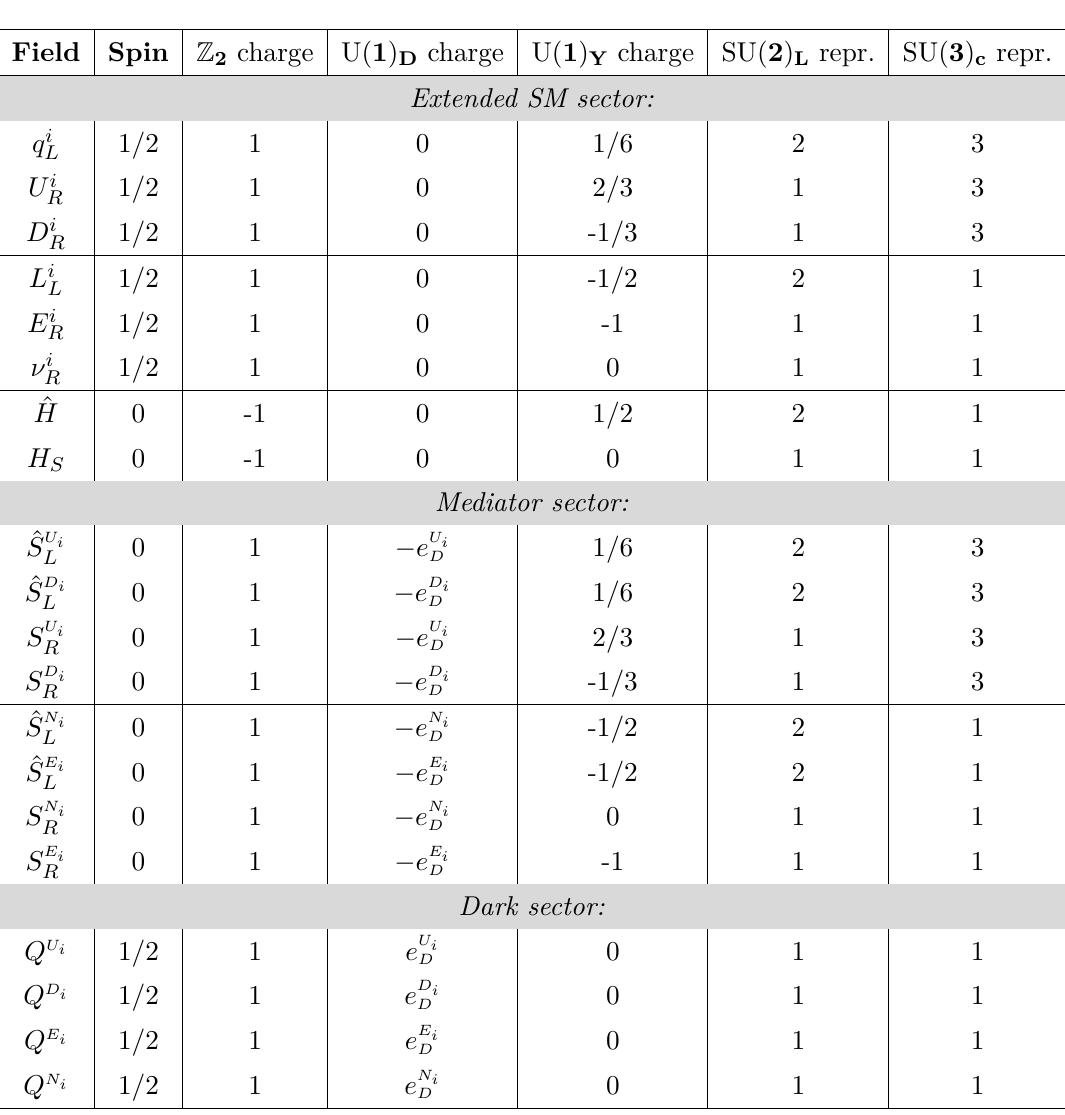
Table 1 . Particle content of the model and gauge assignments. The index i = 1 , 2 , 3 runs over the SM generations. The electric charge of each field is given by Q = I and I is the eigenvalue of the third weak isospin 3